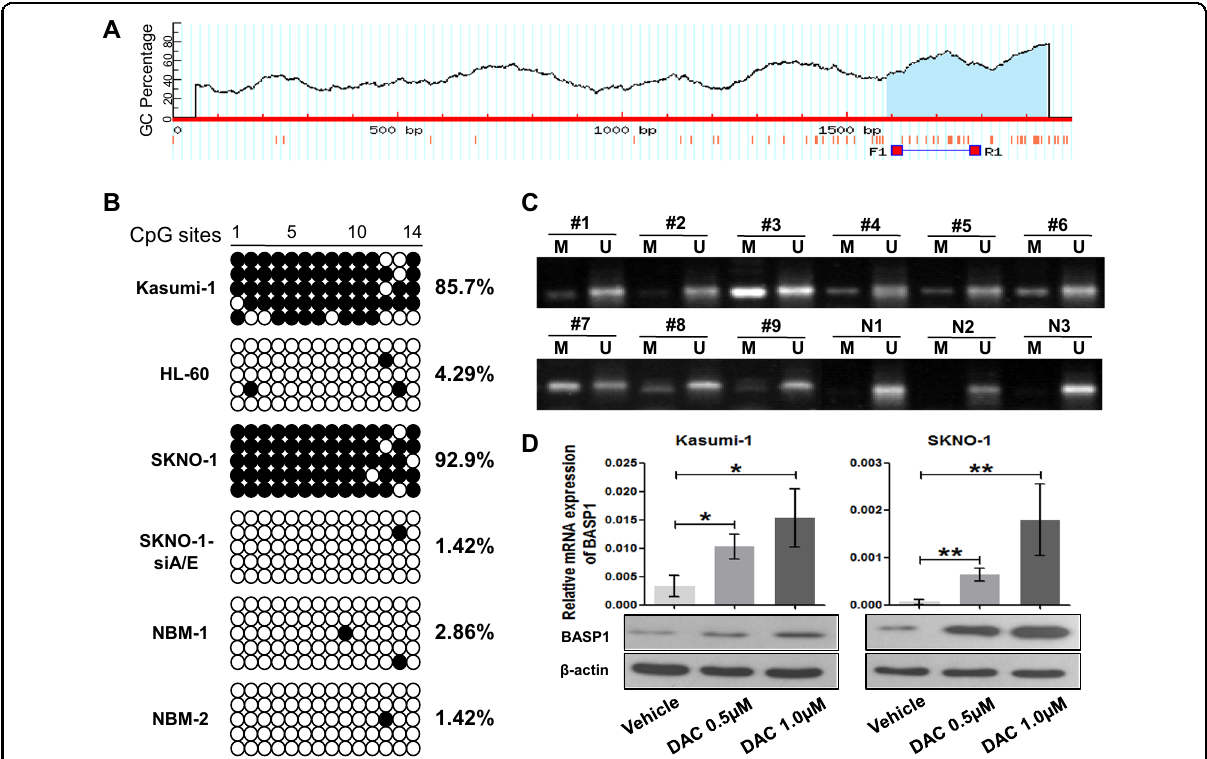
Fig. 2 The BASP1 promoter is highly methylated in A/E-positive AML. a Schematic diagrams of the CpG island of BASP1 promoter sequences ( − 2000 to − 1 bp). The horizontal line (F1 – R1) indicates the location of the primer used in the BSP assays. b Genomic bisulfate sequencing was performed to detect the methylation status of the DNA sequences in the CpG island of the BASP1 promoter from the indicated leukemia cell lines and normal bone marrow. Black dots and white dots indicate methylated and unmethylated CpG cytosine, respectively. c DNA methylation of BASP1 in nine A/E-positive AML cases (#) and three normal bone marrow samples (N) was demonstrated by MSP. M methylated allele, U unmethylated allele. d Upper panel: mRNA expression of BASP1 was up-regulated after continuous treatment with 0.5 or 1.0 µmol/L decitabine (DAC) for 3 days compared to the vehicle in Kasumi-1 and SKNO-1. GAPDH was used as a control. Error bars show the SD from three different assays (* p < 0.05, ** p < 0.01). Lower panel: The protein levels of BASP1 were detected by western blotting. β -Actin was used as a